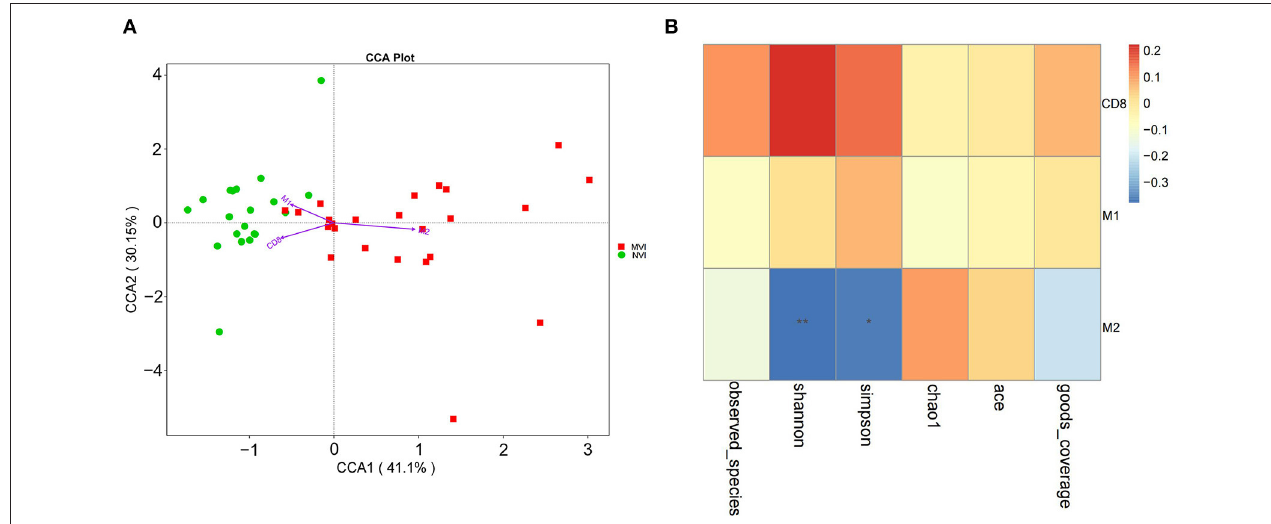
FIGURE 9 | Correlation analysis of TME indicators and intestinal flora. (A) CCA analysis of intestinal flora and CD8 + T cells, M1 and M2-type TAM cells in HCC-MVI and HCC-NVI groups; (B) Spearman correlation analysis of CD8 + T cells, M1 and M2 type TAM cells in HCC-MVI